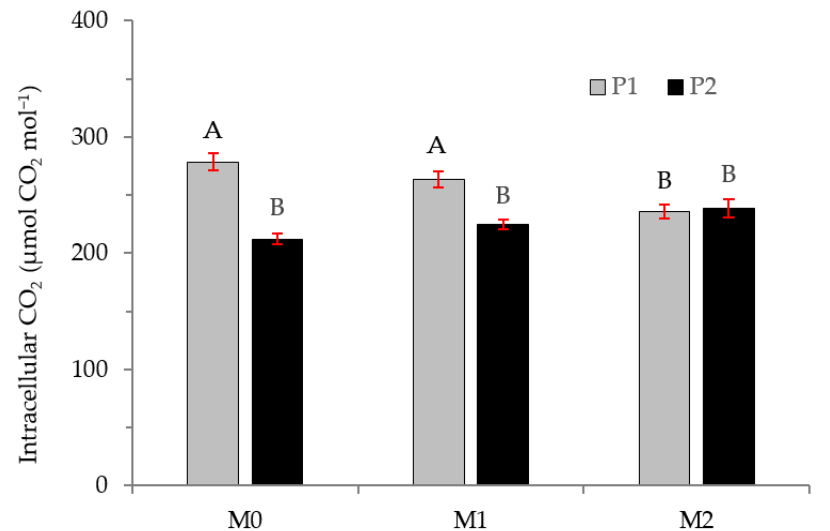
Figure 10. Intracellular CO 2 in Nothofagus. alessandrii plants as a function of MFI treatment (M0, M1, and M2) and plant type (P1 and P2). Di ff erent le tt ers represent signi fi cant di ff erences at p <